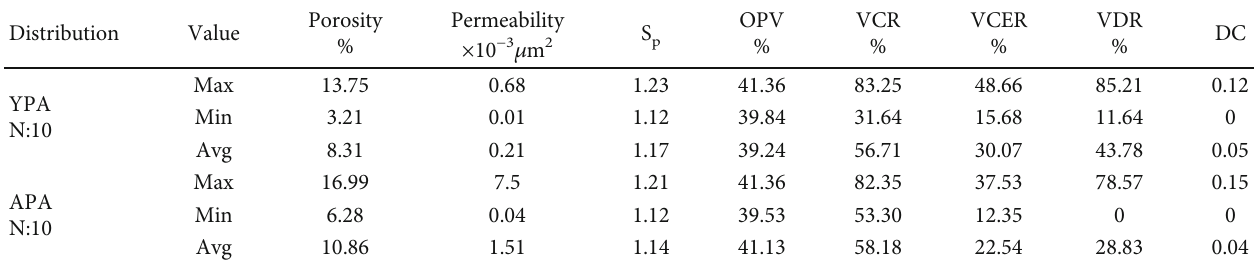
Table 5: Di ff erences in the quantitative characterization of the densi fi cation process of the YPA and APA reservoirs. Distribution